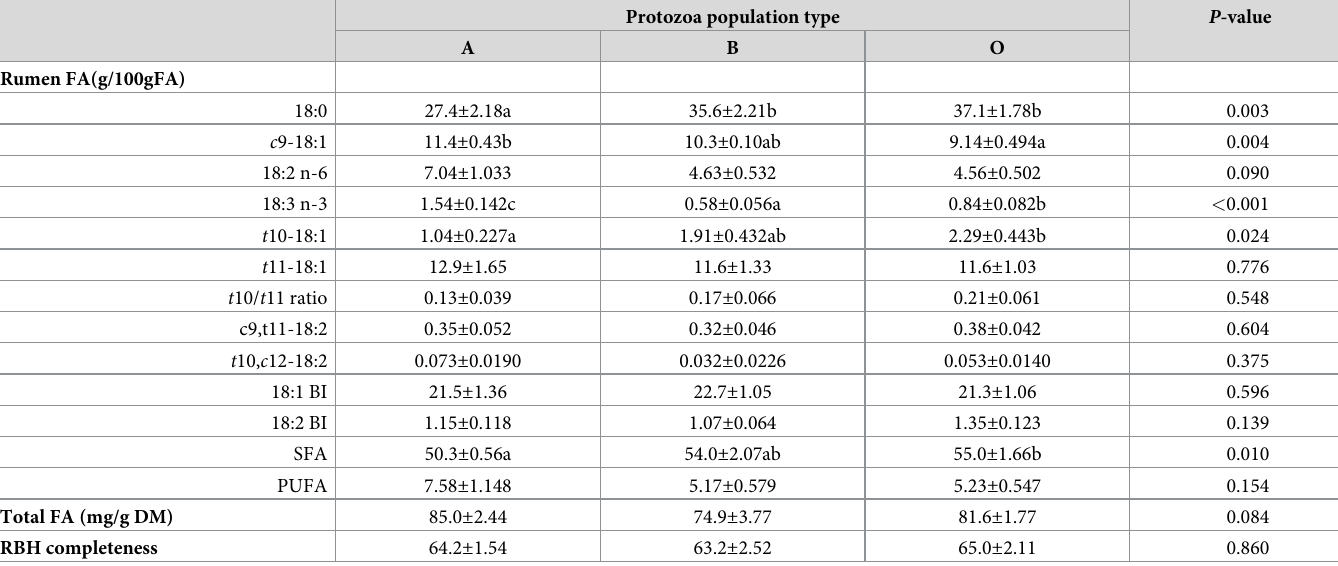
Table 7. Effect of the type of protozoa population in rumen fatty acids.